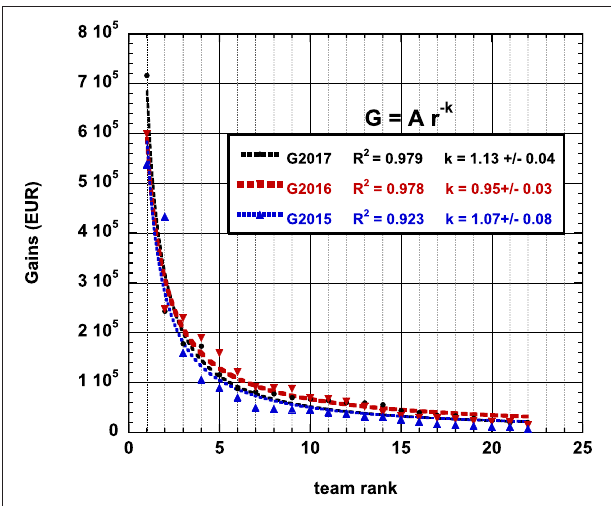
FIGURE 1 | Display of team financial gains in Tour de France 2017, 2016, and 2015.